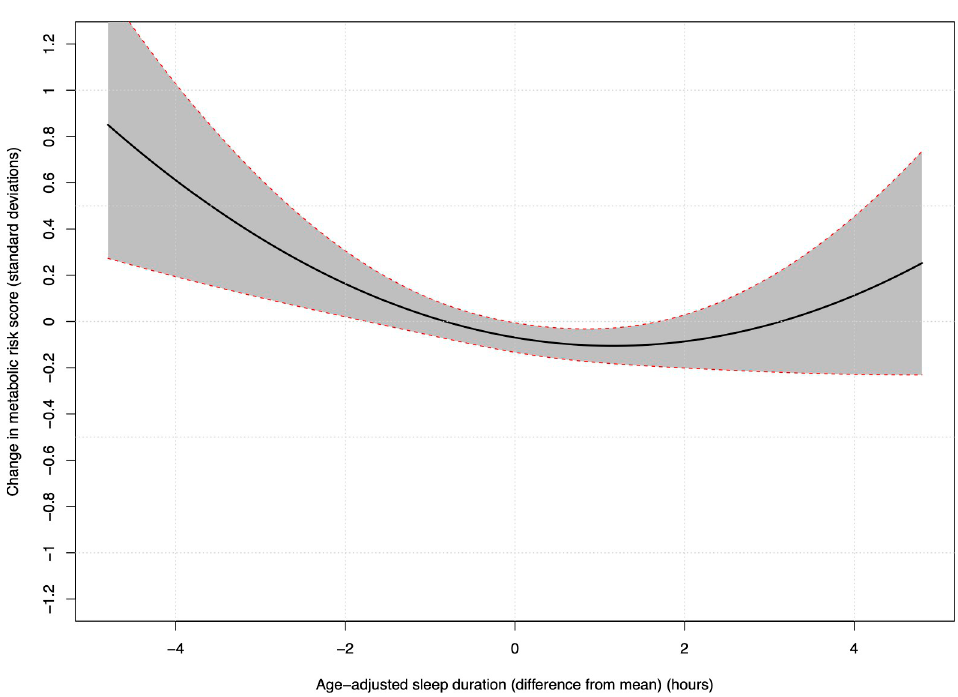
Fig 2. Model predictions of metabolic risk score. Model predictions of metabolic risk score (with 95% confidence intervals) as sleep durations vary above and below the mean (model 3, all age groups).